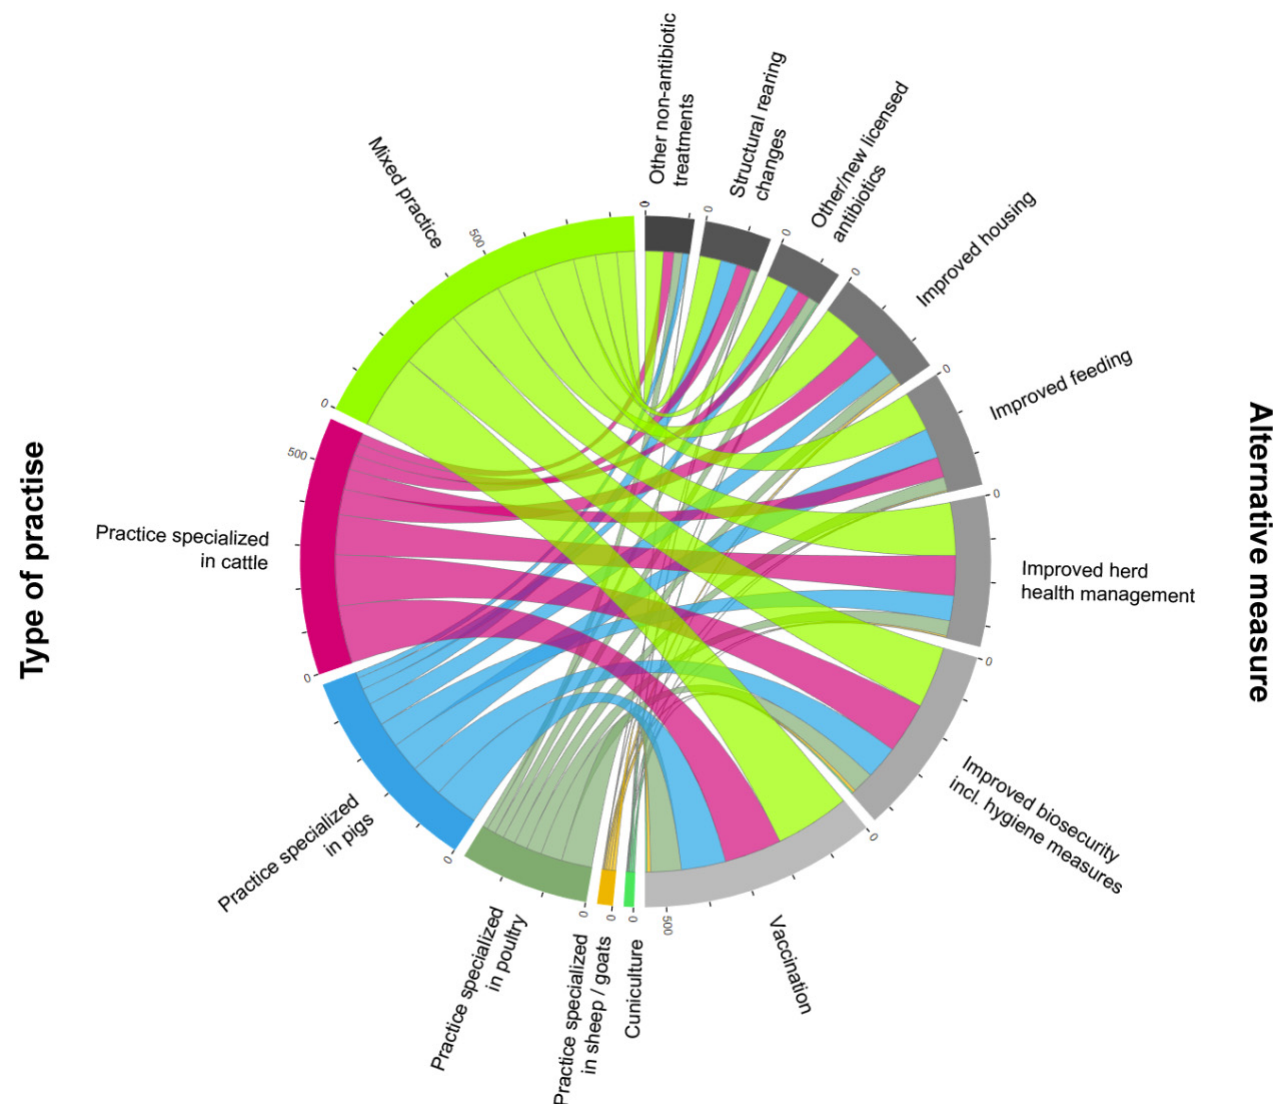
Figure 4. Chord diagram displaying the inter-relationship between most effective alternative measures to prevent and avoid the need for metaphylactic treatment per practice type (Q9 with n = 2329 responses, multiple answers possible). Arc lengths on the outer circle are proportional to total quantities. Plotted with JavaScript in HTML based on an open library from https://d3js.org/ (accessed on 31 March 2022).